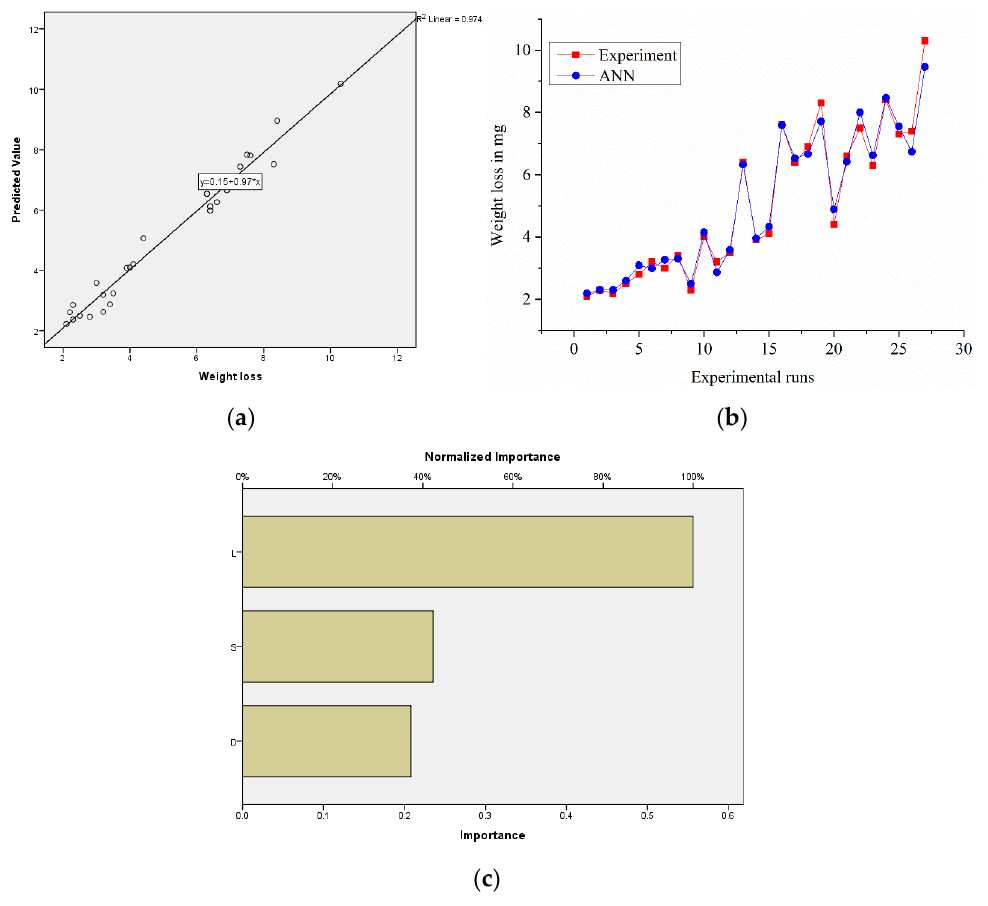
Figure 14. ( a ) Experimental vs. predicted values of the samples; ( b ) error-values; ( c ) normalized factor importance.